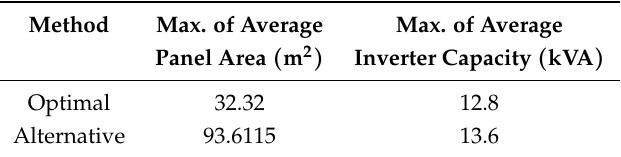
Table 8. Comparison of optimal and alternative design—maximum average panel area and average inverter capacity ( B n = 24).